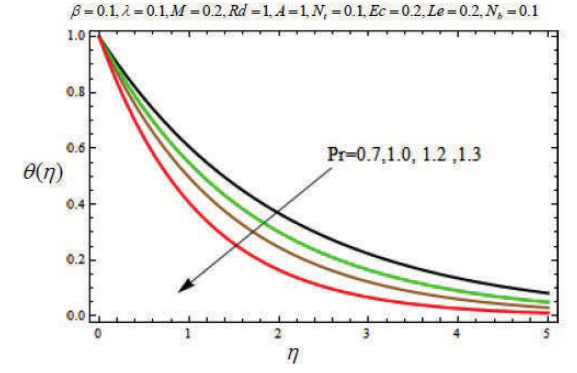
Fig. 8: Variation of temperature profile θ ( η ) with η for several values of thermophoresis parameter N t .